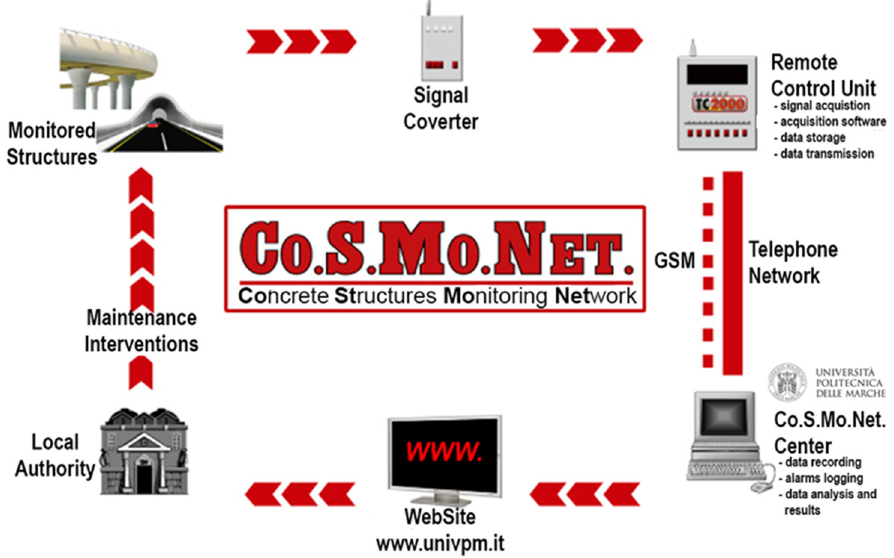
Figure 2. The Co.S.Mo.Net monitoring system.